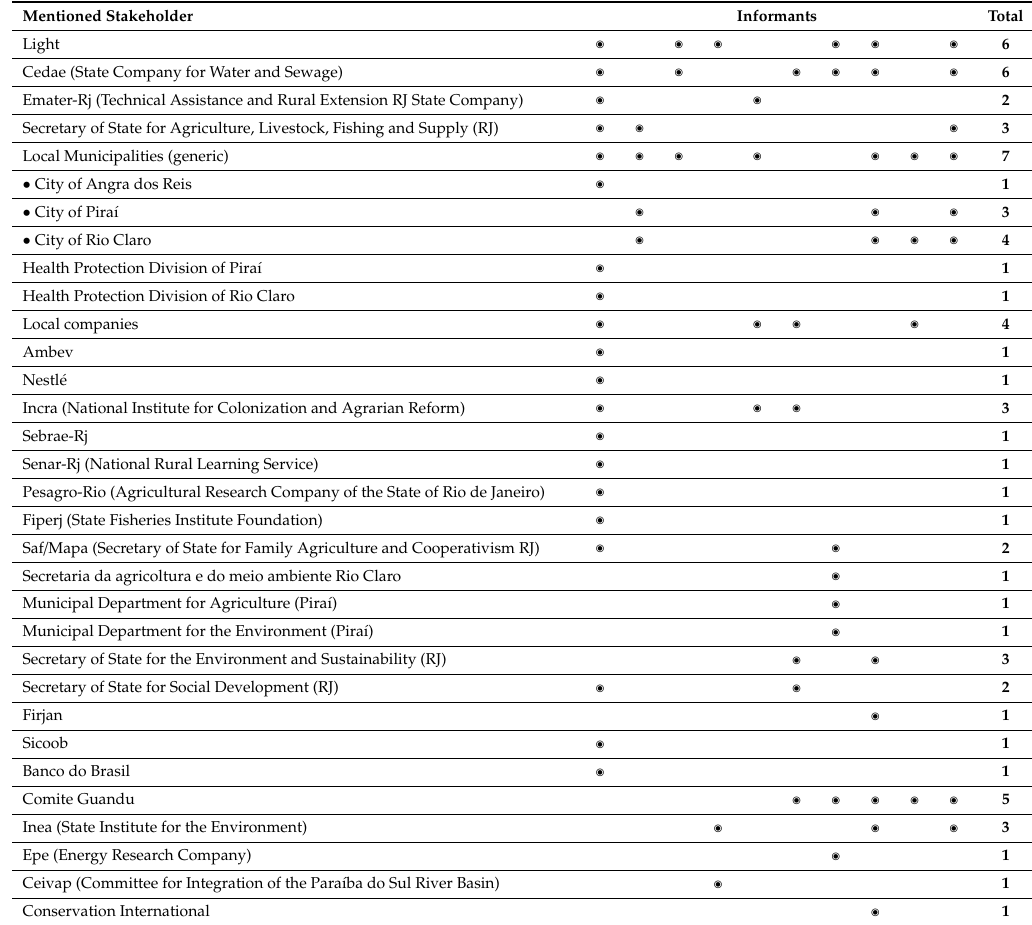
Table 1. Frequency of stakeholders mentioned by di ff erent informants. The columns anonymously indicate the answers of the